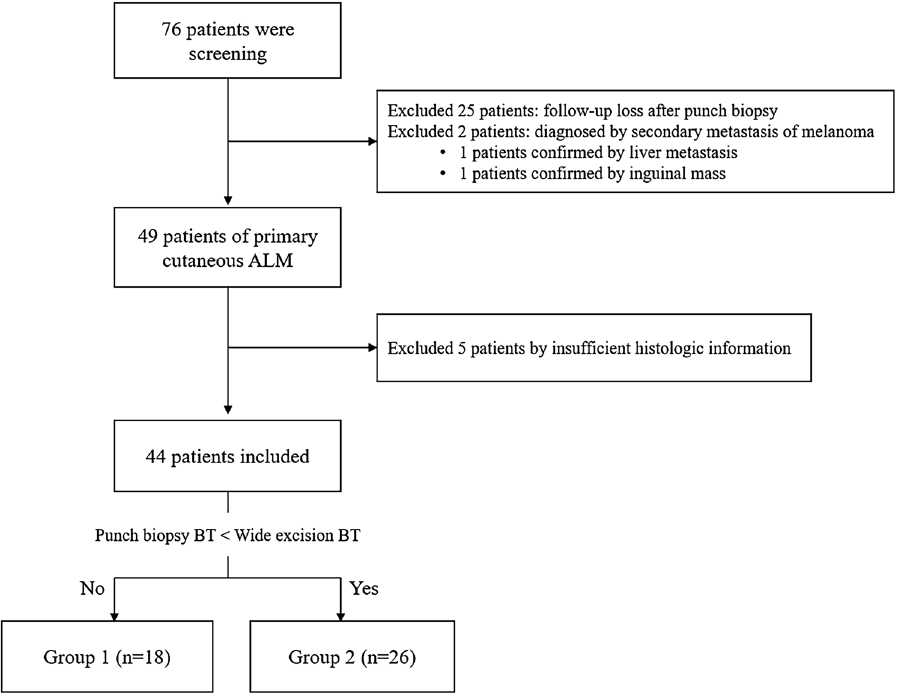
Figure 2. Flowchart describing our study population. BT Breslow